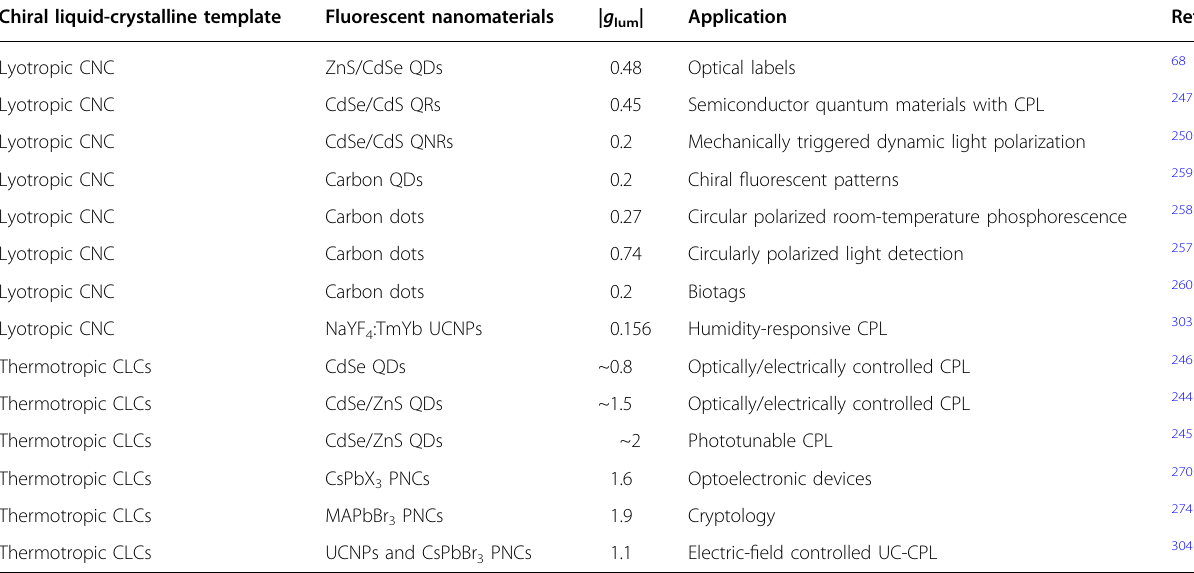
Table 1 Chiral luminescent nanomaterials based on chiral liquid-crystalline templates Chiral liquid-crystalline